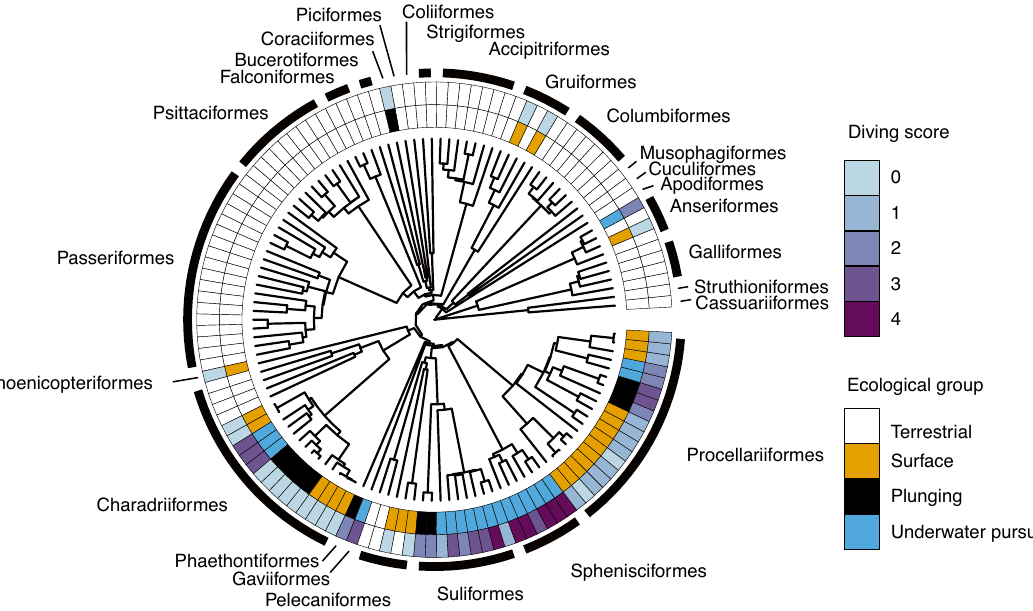
Figure 2. Phylogeny of species included in this study, labelled by four ecological groupings (terrestrial, surface- foraging, plunge-diving, and underwater pursuit) (inner ring), and classification of dive capability with highest point scores corresponding to deepest divers (outer ring). The phylogeny was constructed using a backbone based on published trees 13 and species-level relationships using a ‘Hackett Stage 2’ phylogeny available online (www. birdt ree.